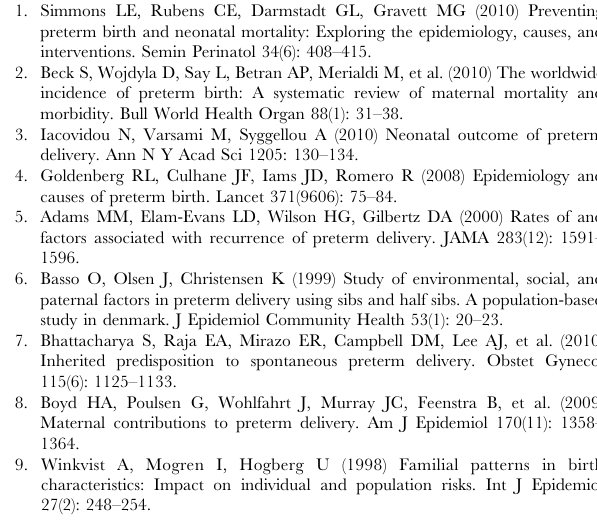
Figure S1 AR CAG repeat distributions in the initial case-control population. Table S1 Gestational ages and years of birth for the preterm-born members of the seven families with recurrent SPTB analyzed in the linkage analysis of X chromosomal markers. Table S2 AR CAG repeat distributions in male and female SPTB and term